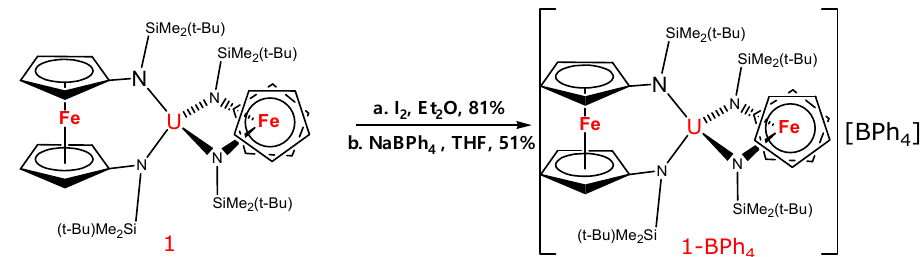
Figure 31. The transformation reaction of 1 U(fc[NSiMe 3 ] 2 ) 2 into [Fe II U IV Fe III (C 5 H 4 NSi( t Bu)Me 2 ) 4 ]BPh 4 : 1 -BPh4 [18].